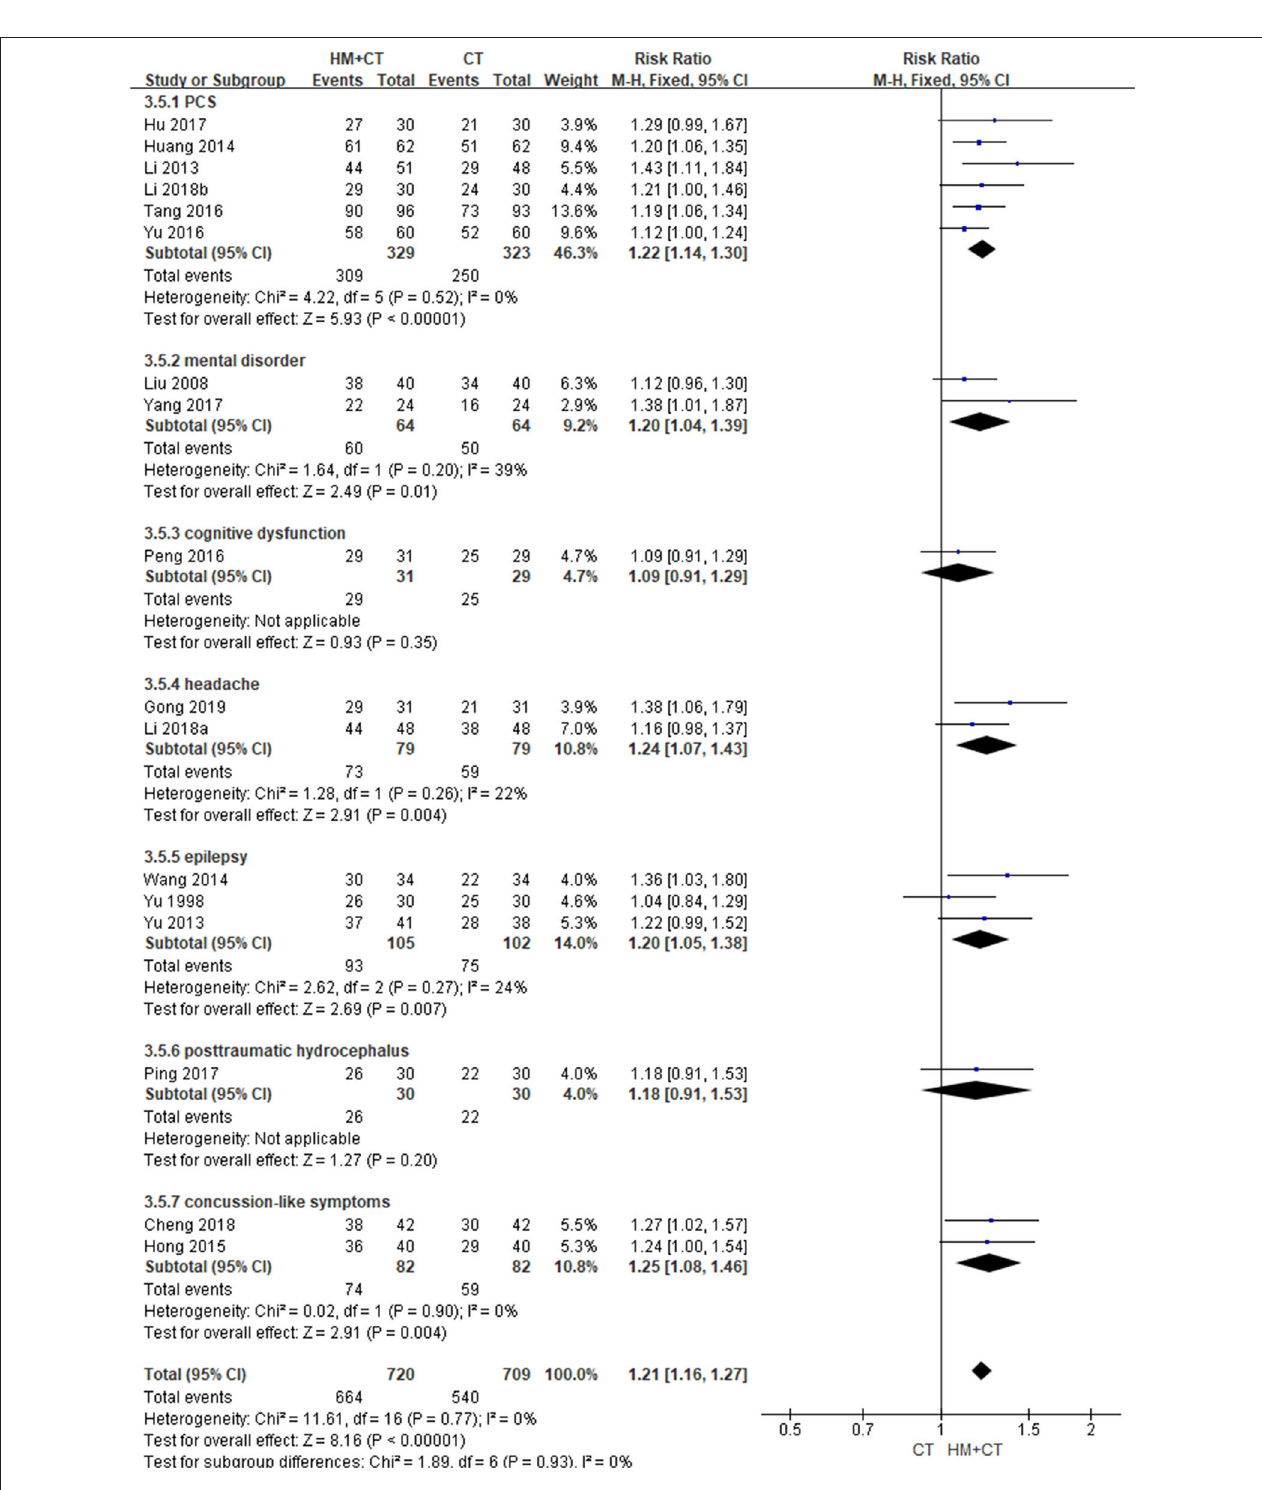
FIGURE 5 | Total effective rate based on clinical symptoms (Comparison of herbal medicine combined with conventional treatment vs. conventional treatment alone).